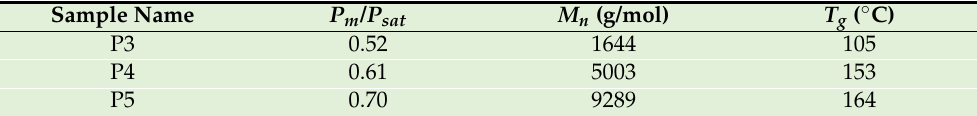
Table 2. The effect of PMBL molar mass ( M n ) on glass transition temperature ( T g ).